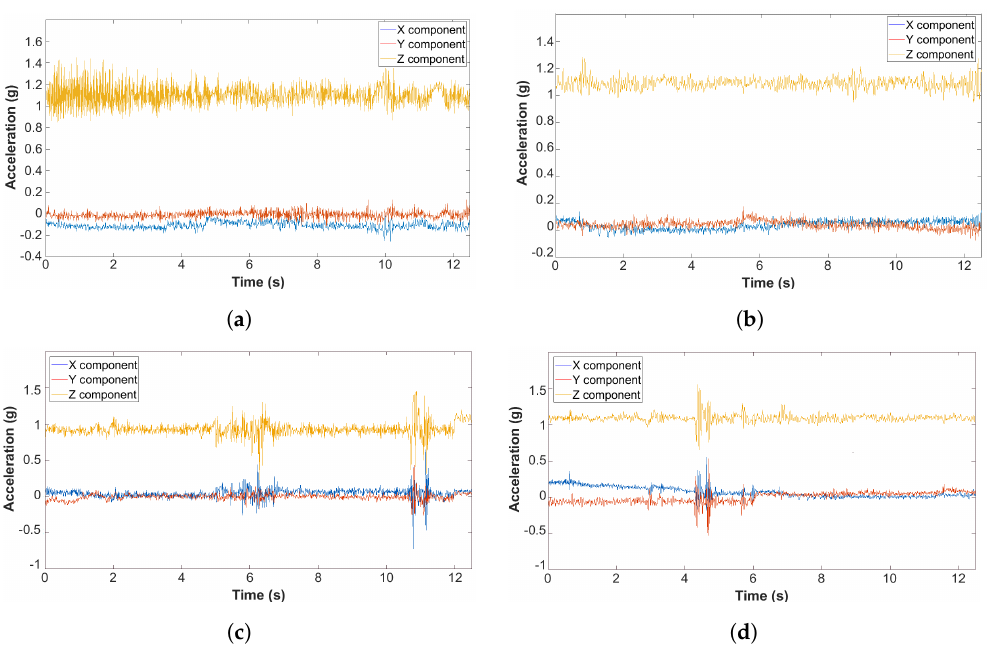
Figure 2. Examples of acceleration signals for different road pavement conditions and different on-car sensor placements. ( a ) Good pavement surface (car’s dashboard); ( b ) Good pavement surface (car’s floorboard); ( c ) Presence of potholes (car’s dashboard); ( d ) Presence of potholes (car’s